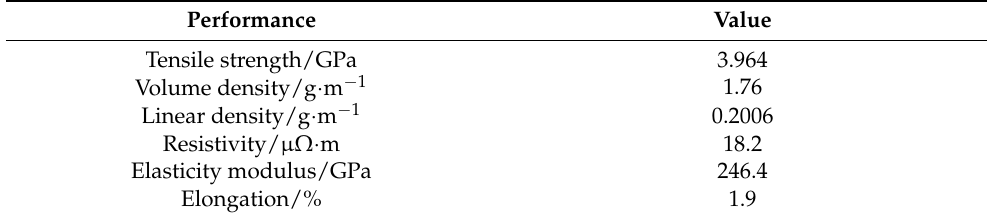
Table 1. Comprehensive properties of carbon fiber.